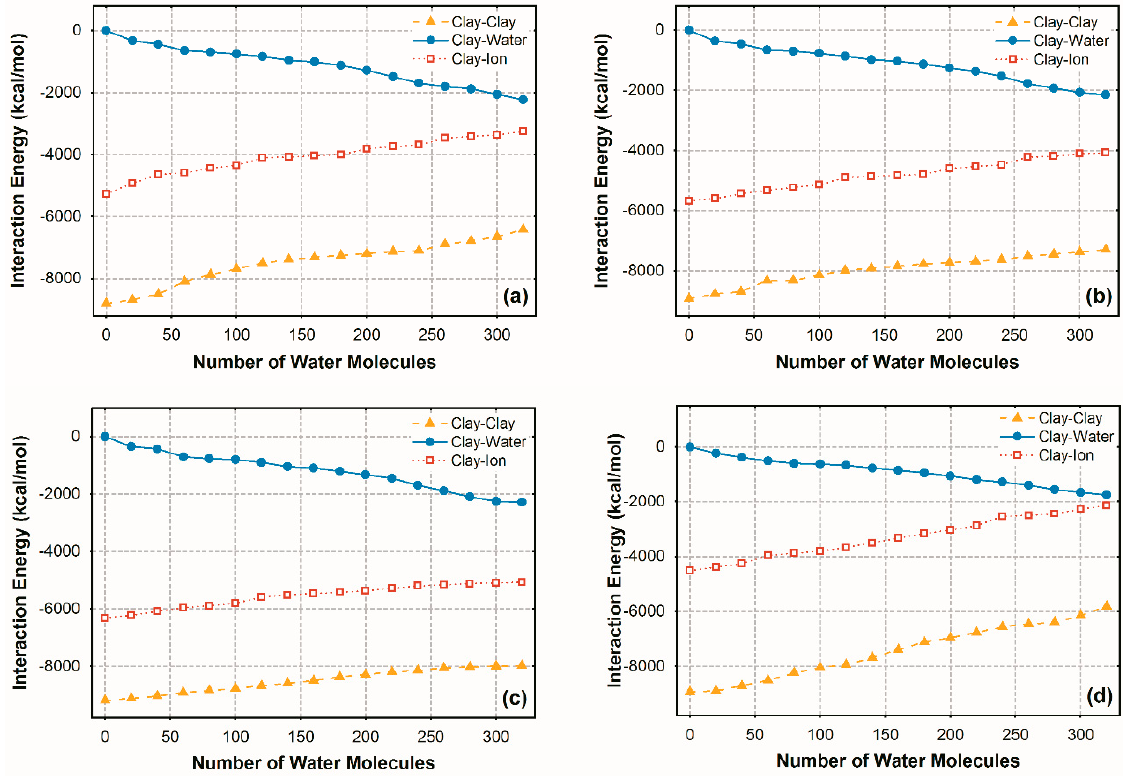
Figure 4. Evolution of interaction energies with increasing water content for four types of clay; ( a ) I-MMT with 50% Na + and 50% K + ; ( b ) I-MMT with 25% Na + and 75% K + ; ( c ) I-MMT with K + only; ( d ) MMT-MMT with Na + only. The results for clay-clay interaction energy are represented by yellow, clay-water interaction energy by blue, and clay-ion interaction energy by red; negative values of interaction energies indicate attractive